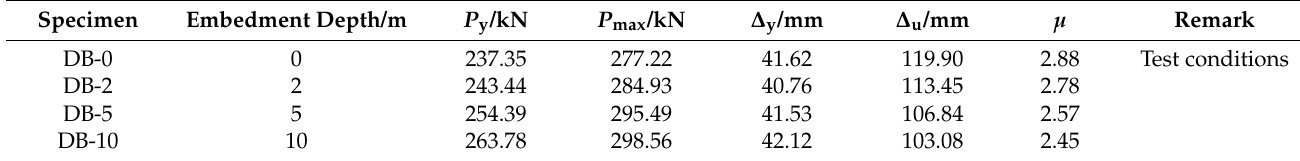
Table 5. Analysis parameters and calculation results of embedment depth.